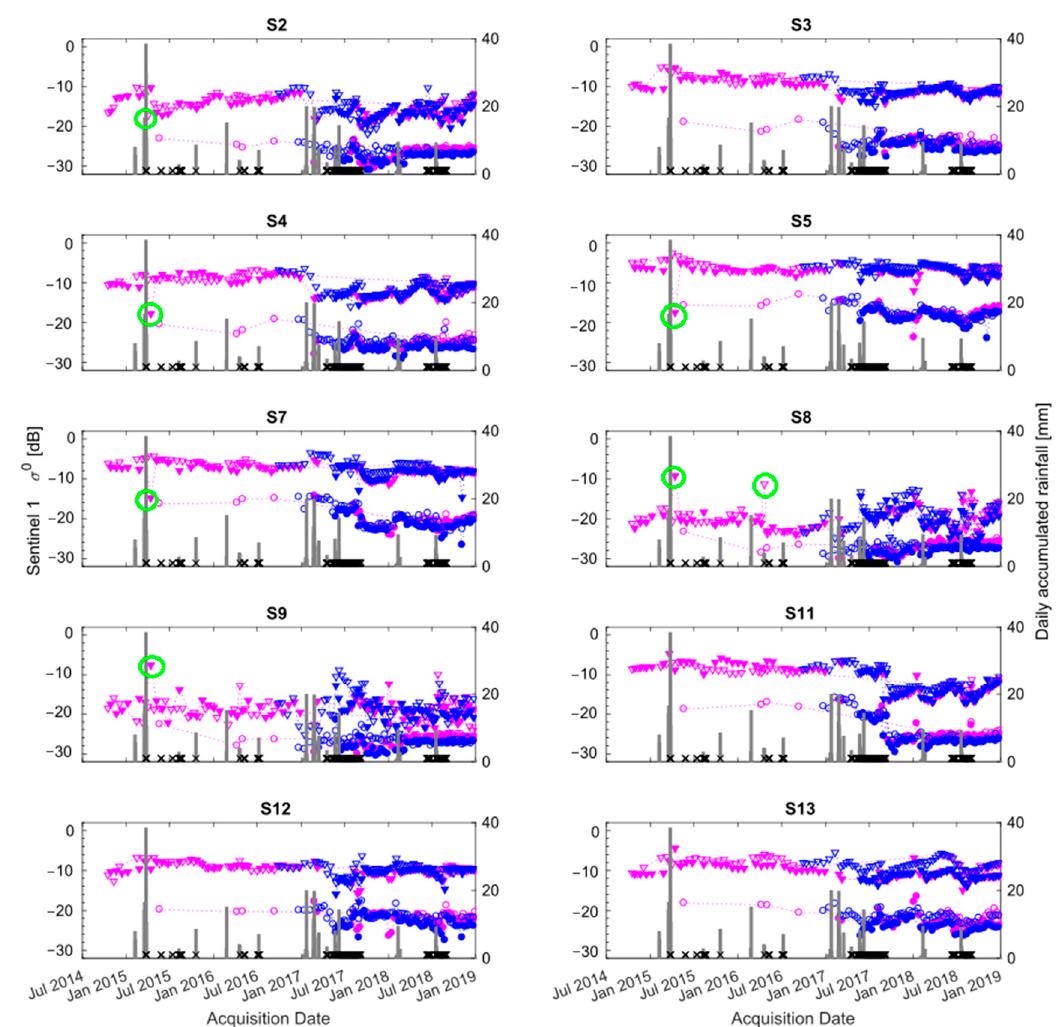
Figure 11. Sentinel 1 temporal backscattering observed over the salt pan for the remaining sites considered in this study. Sentinel 1A (magenta) and Sentinel 1B (blue) in ascending (full markers) and descending (empty markers) orbits. VV polarization is indicated as triangles, and VH are circles. The green circles indicate episodic events: on 13 April 2015, for sites S4, S5, S7, S8, S9, and 20 April 2016, for site S8. Daily accumulate rainfalls recorded at Socaire are in grey bars, and snowfall cover also shown as black crosses.